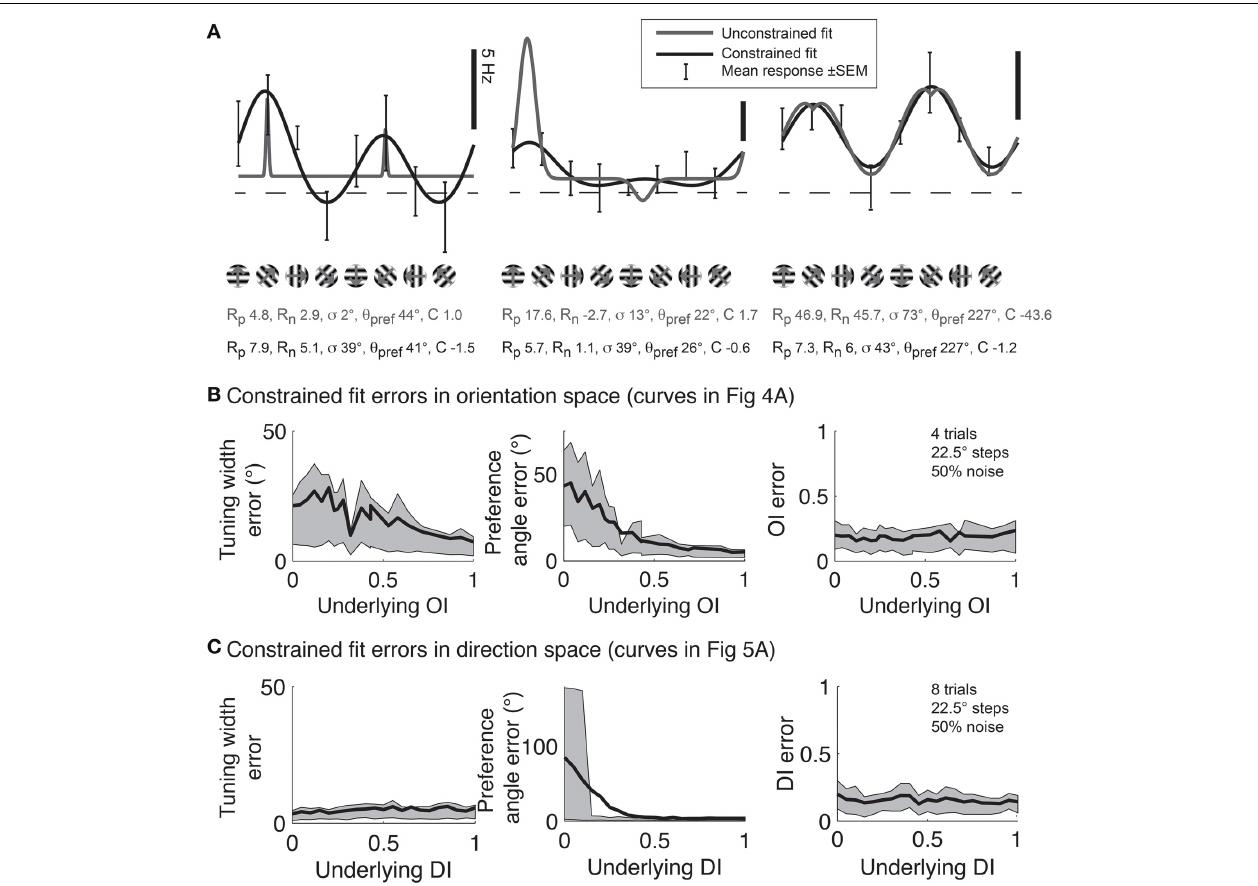
FIGURE 11 | Gaussian fits for assessing orientation and direction selectivity. (A) Common errors with unconstrained fits (gray lines). Left: the unconstrained fit has gotten stuck in a local squared error minimum, using a tiny tuning width to fit 2 points very accurately. Middle: The unconstrained fit has used a peak response R p that is much larger than any point actually present in the data, and a physiologically implausible negative weight for the null direction. Right: The unconstrained fit has found a reasonable fit, but the parameters do not make physical sense. The unconstrained fit posits a